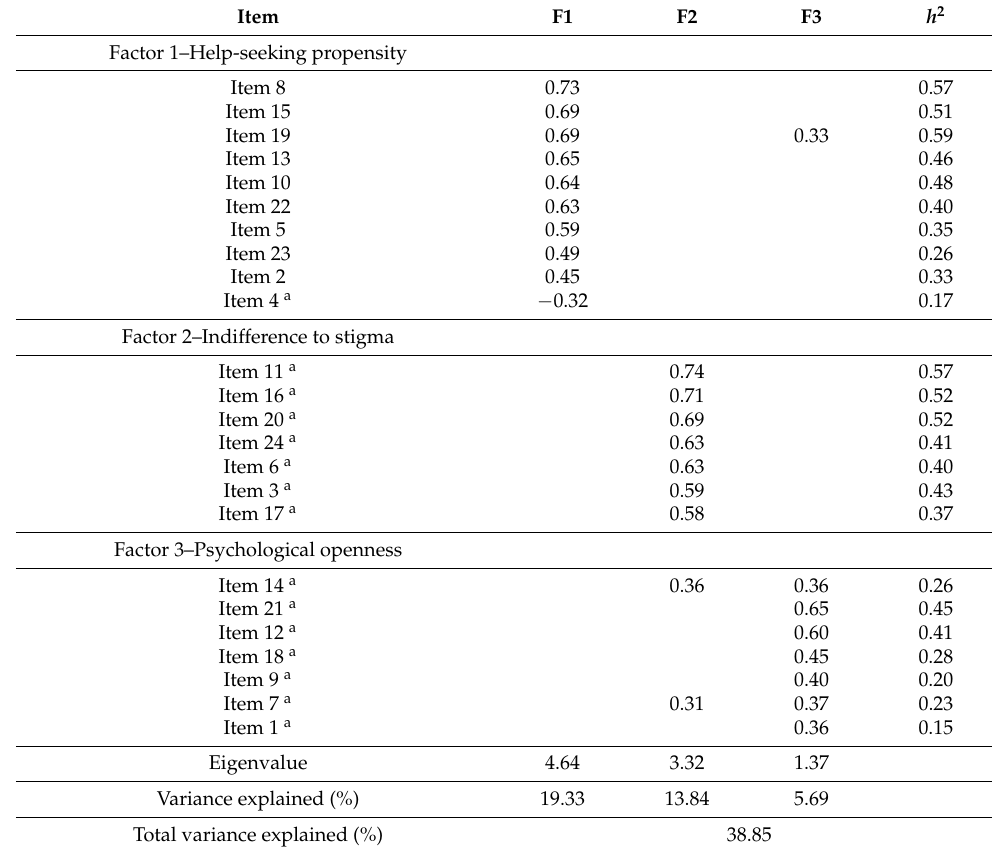
Table 1. Exploratory Factor Analysis of the